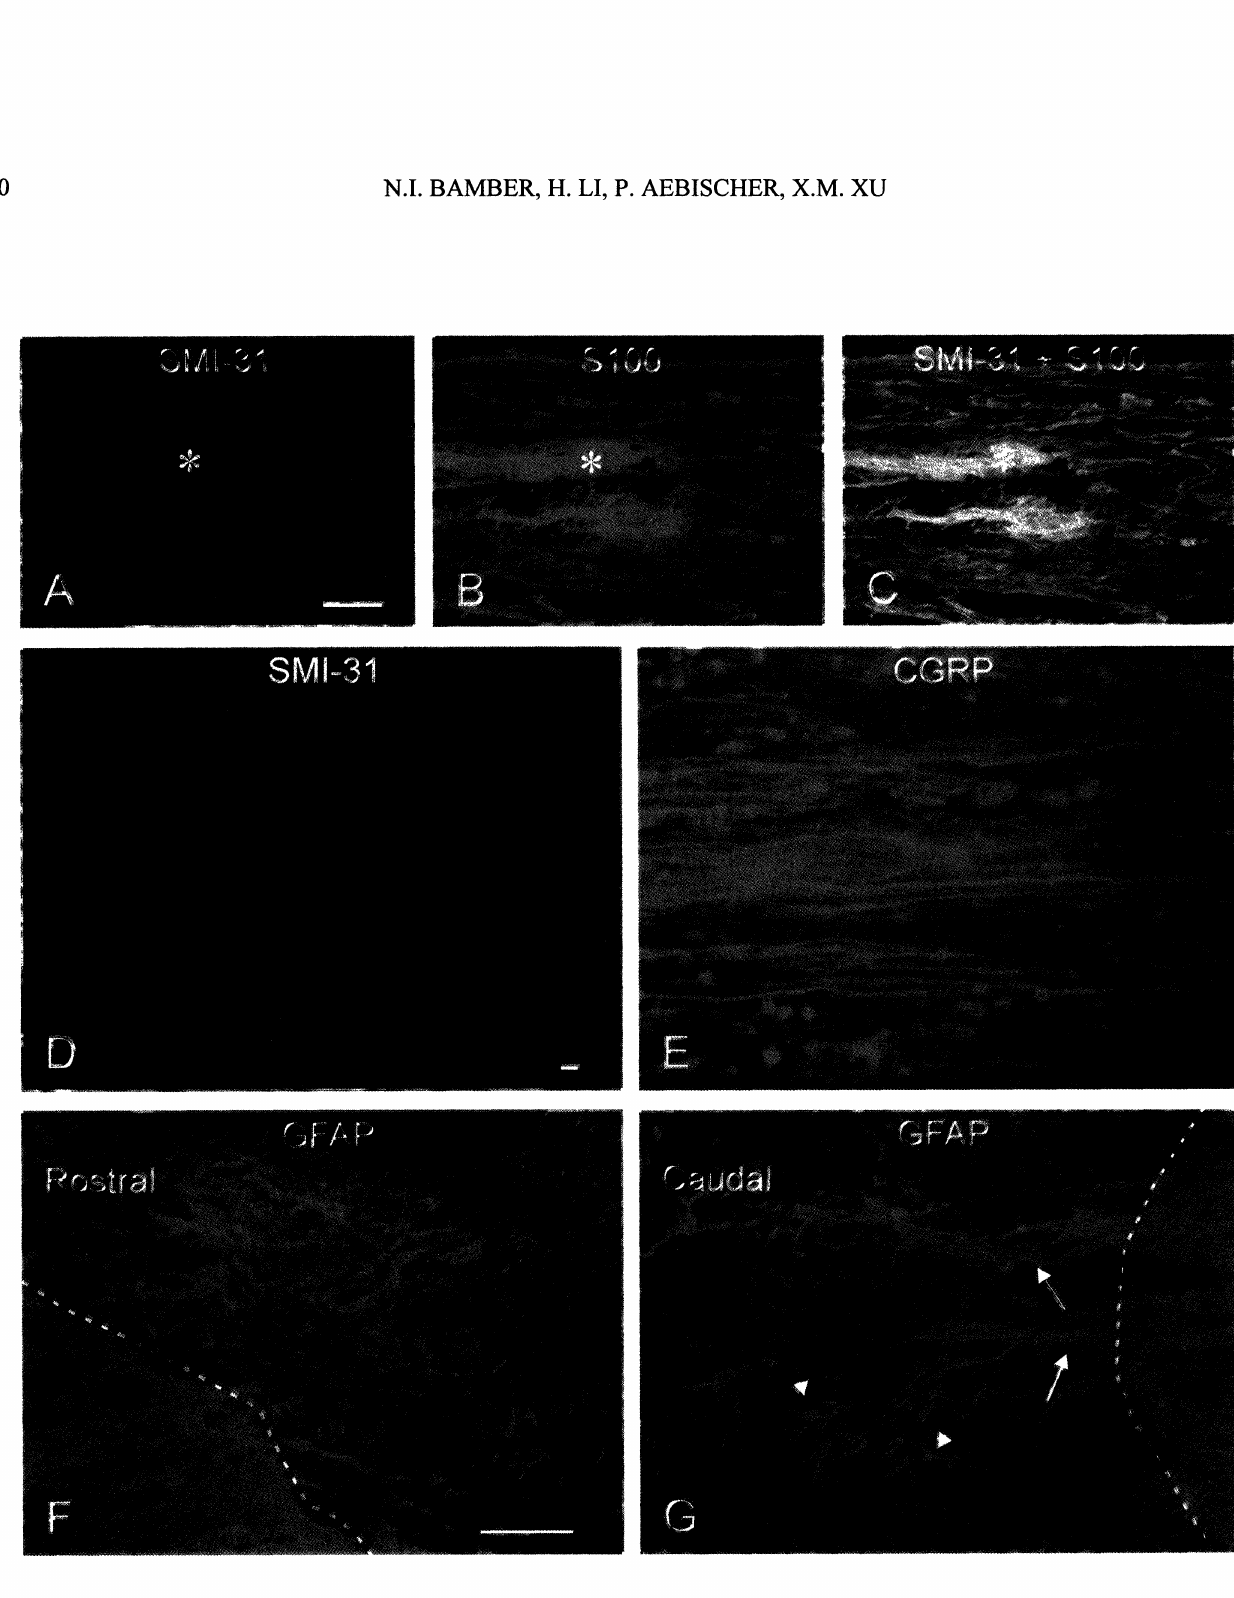
Fig. 3" A-C: Fluorescence photomicrographs demonstrating islands of FSC tissue (asterisks) present 30 days after transplantation. Clusters of axons recognized by SMI-31 immunolabeling (A) overlapped with S100 immunopositive astrocytes/Schwann cells (B). Islands of tissue with intense, overlapping labeling for both SMI-31 and S100 were interpreted as surviving FSC tissue (C). D" SMI-31 immunolabeling demonstrates arrays of axons elongating longitudinally along the long axis of the FSC graft. E: A sub-population of axons within FSC grafts were immunopositive for CGRP. F-G" GFAP immunostaining demonstrates a mild astrogliotic reaction at the interface between the host and FSC graft ( ). GFAP immunopostive processes from the host were observed to interdigitate with the graft tissue (G, arrows), and individual astrocytes (G, arrowheads) were seen to be present within the graft. Bars: A-C 100tm; D-E 10pm; F-G